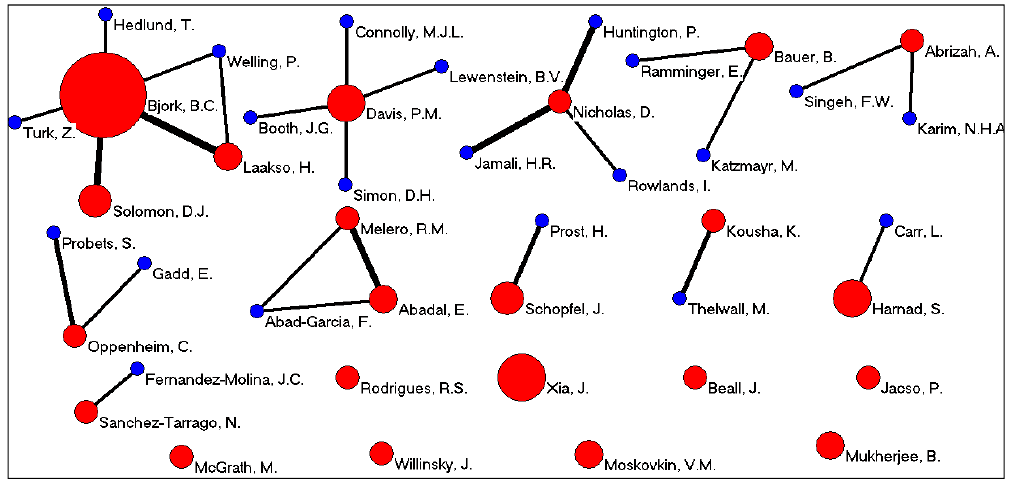
Figure 2. Collaborative network among the 22 most productive authors who had at least two co ‐